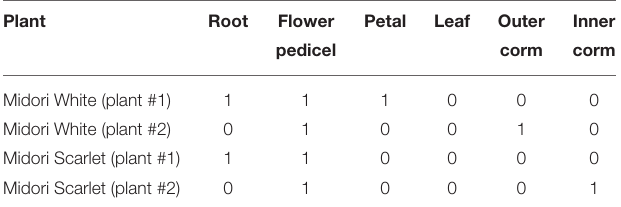
TABLE 3 | Recovery of Botrytis from different tissues of four Cyclamen persica plants cv. Midori earlier inoculated and diseased, but recovered and symptomless at the time of